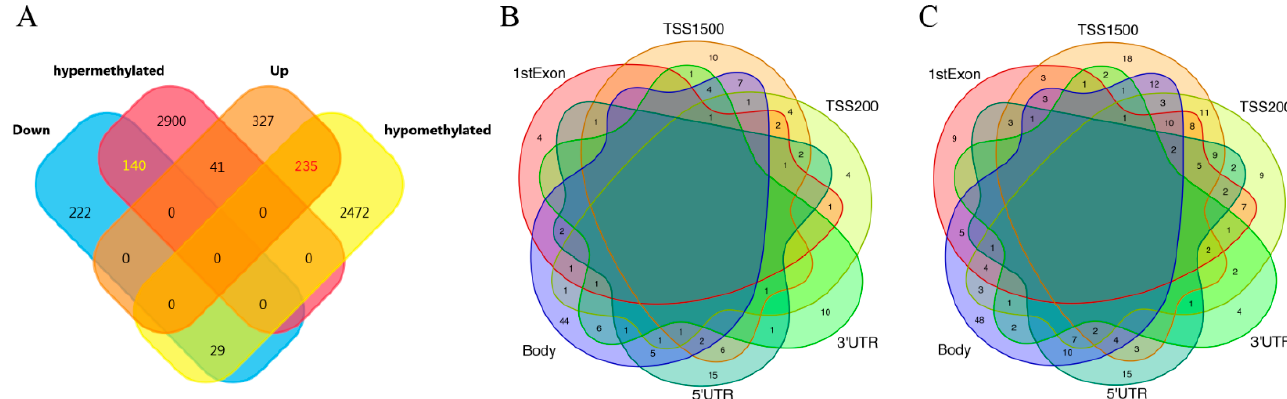
Figure 4. Integration analysis of aberrantly methylated-differentially expressed genes (AMDEGs) and distribution of AMDEGs based on different region CpGs. ( A ) Venn diagram showing the overlapping aberrantly methylated differentially expressed genes (AMDEGs). Venn plot for ( B ) hyper-down genes and ( C ) hypo-up genes in AS in different regions. Hyper-down genes represent hypermethylated and downregulated genes. Hypo-up genes represent hypomethylated and upregulated genes.